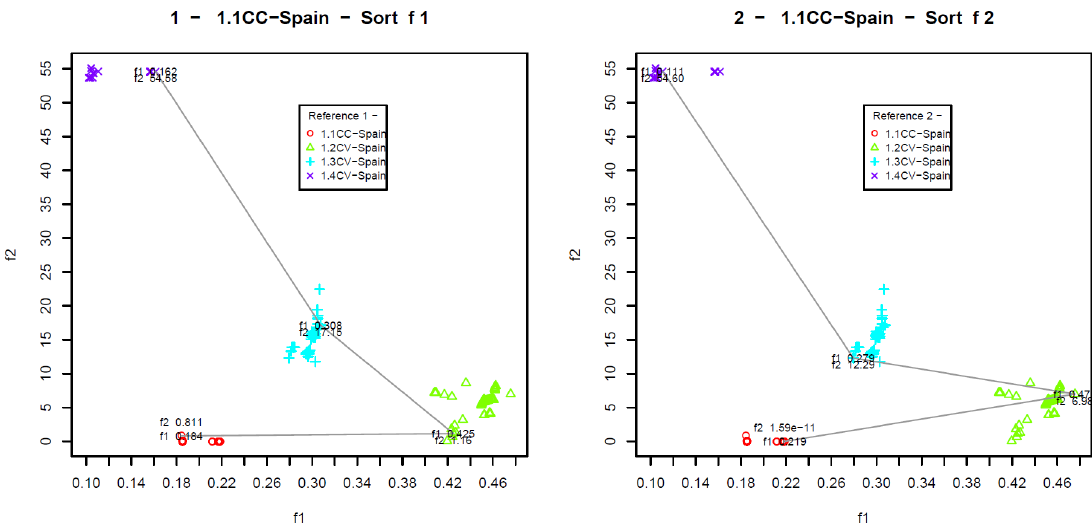
Figure 6. Strategy of solution selection for problem 1 (Asua river basin). Selection of two possible solutions from the reference front (after calibration 1.1CC) limits and corresponding to solutions in validation